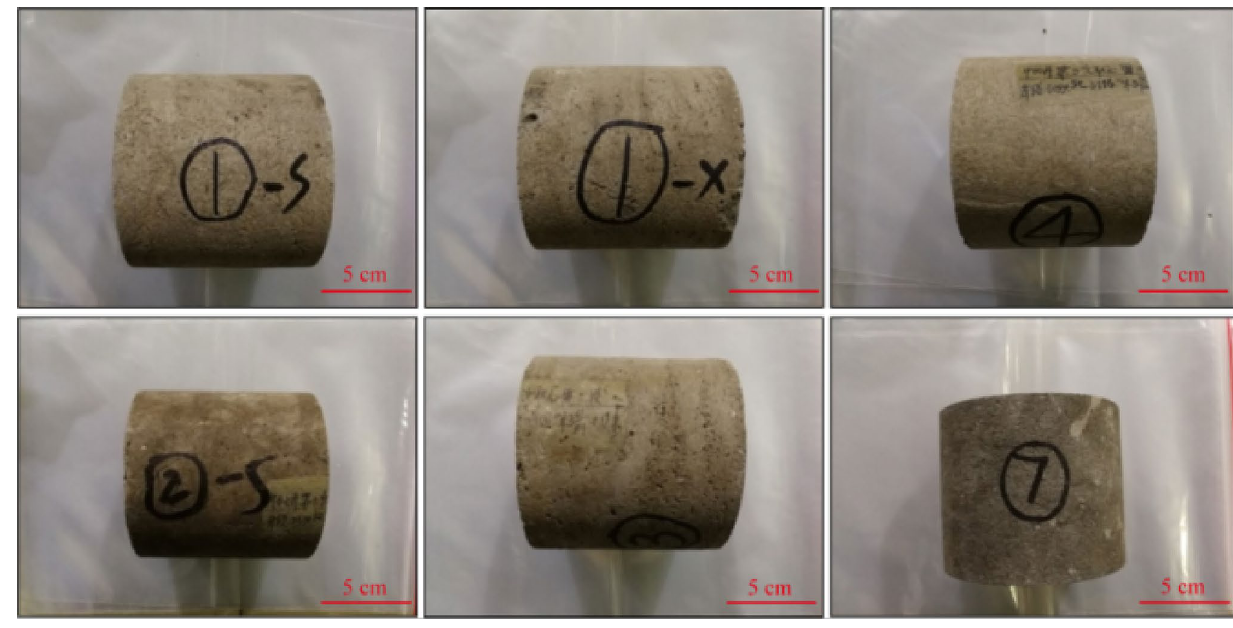
Fig. 4 Full diameter core samples of part carbonate rocks